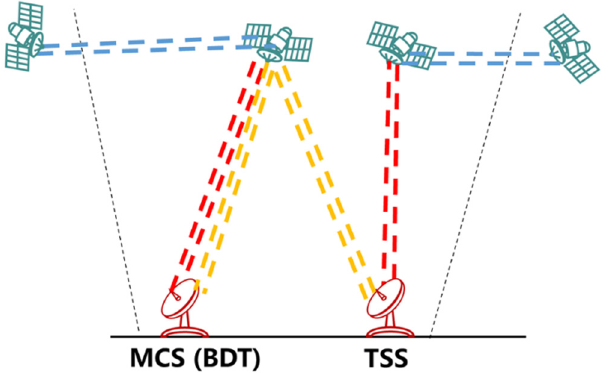
Figure 1. The construction of BDS time synchronization and the basic two-way measurements of BDS-3. Wherein, the red, blue, yellow curves are L-band satellite-station two-way measurements, Ka-band inter-satellite measurements, C-band inter-station two-way measurements,